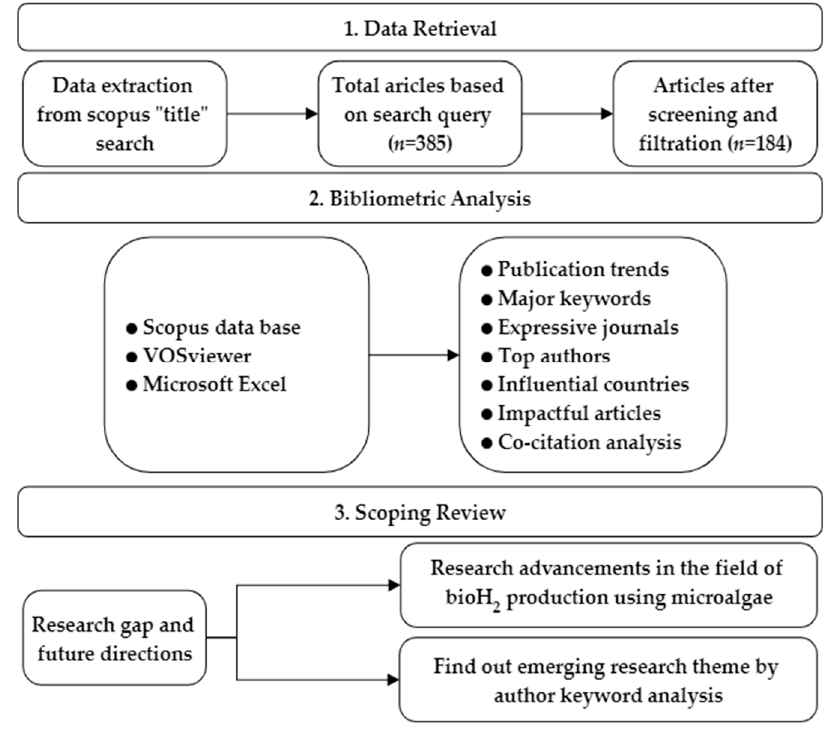
Figure 2. Research methodology flowchart. ( n : number of articles).